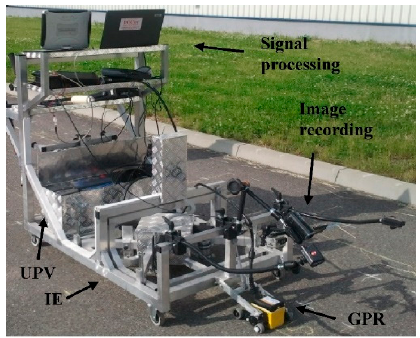
Figure 18. UIR-Scanner (a prototype) for nondestructive testing using complementary NDT methods: GPR (Ground Penetrating Radar), IE (Impact-Echo) and UPV (Ultrasonic Pulse Velocity) equipped with computer systems for signal analysis.